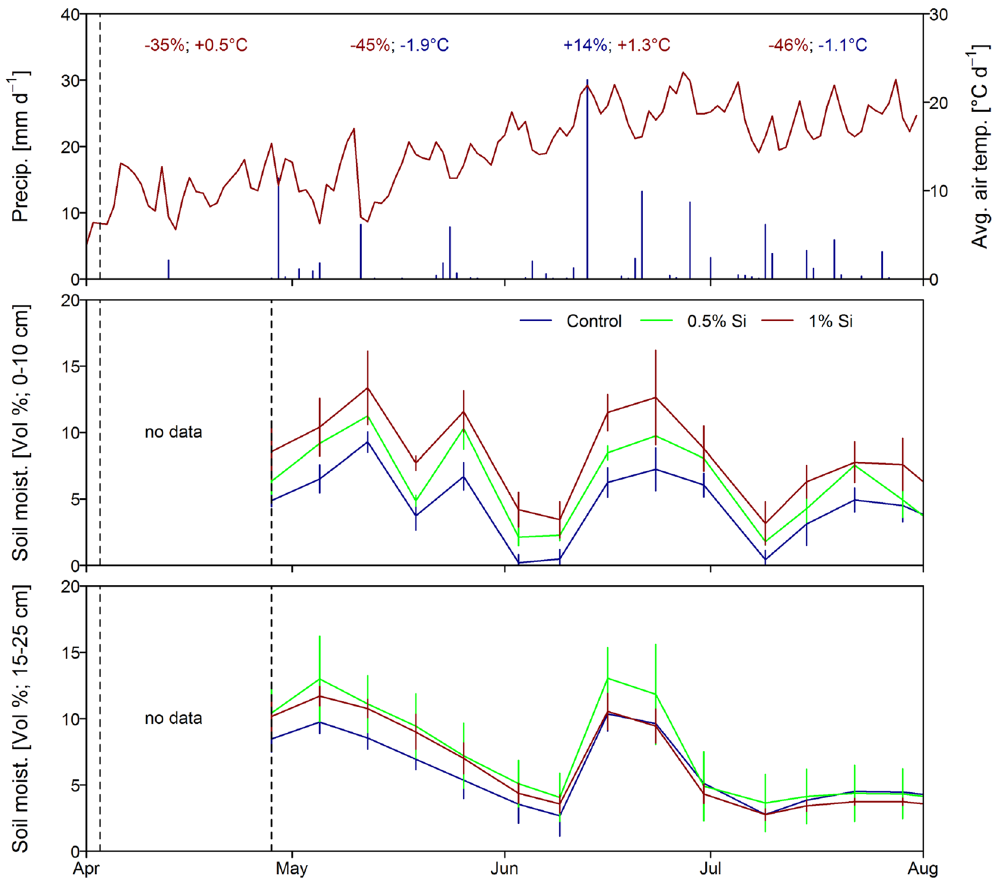
Figure 1. Daily precipitation (mm) and average air temperature (°C) during the crop growth period (top panel). Monthly precipitation and temperature difference (compared to 30 years average monthly precipitation and air temperature; 1990–2020 DWD Station Müncheberg) is given in the top; Corresponding average soil moisture (Vol%) for the uppermost soil layer (0–10 cm; middle panel) and for the depth of 15–25 cm (bottom panel). Error bars indicate the ± 1 SD.